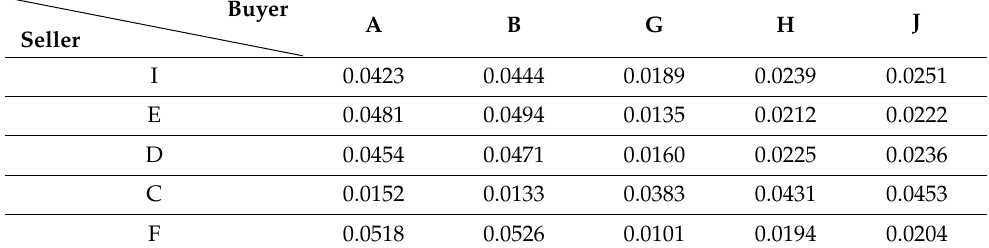
Table 5. The cost path in